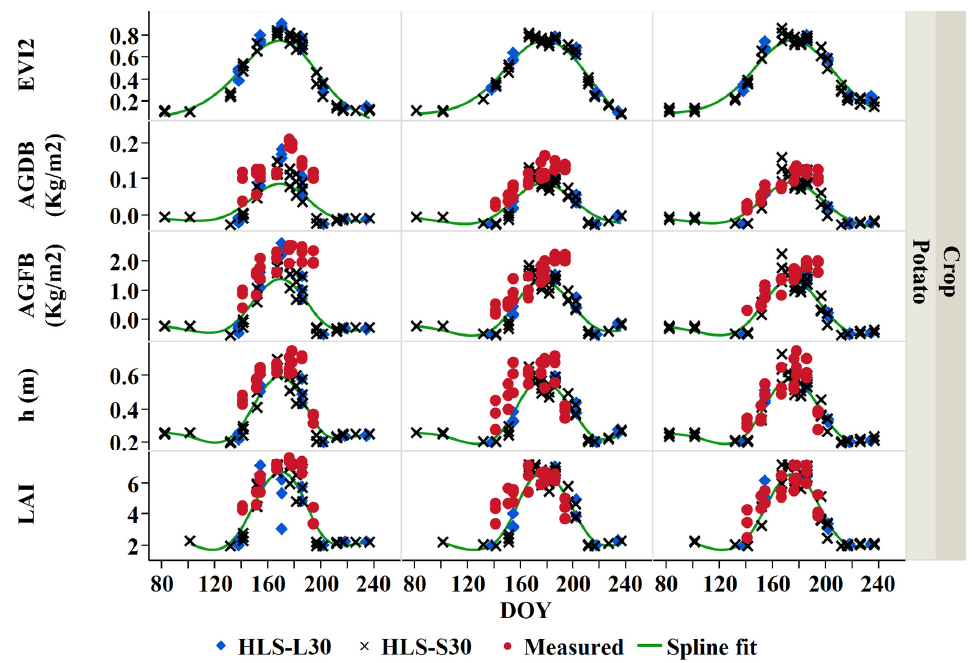
Figure 15 . A combined L30 and S30 derived and measured biophysical parameters (EVI2, above ‐ ground fresh biomass (AGFB), above ‐ ground dry biomass (AGDB), height (h), and leaf area index (LAI) time ‐ series of potato for three farms during the 2019 growing season, modeled (both L30 and S30) crop biophysical in green spline